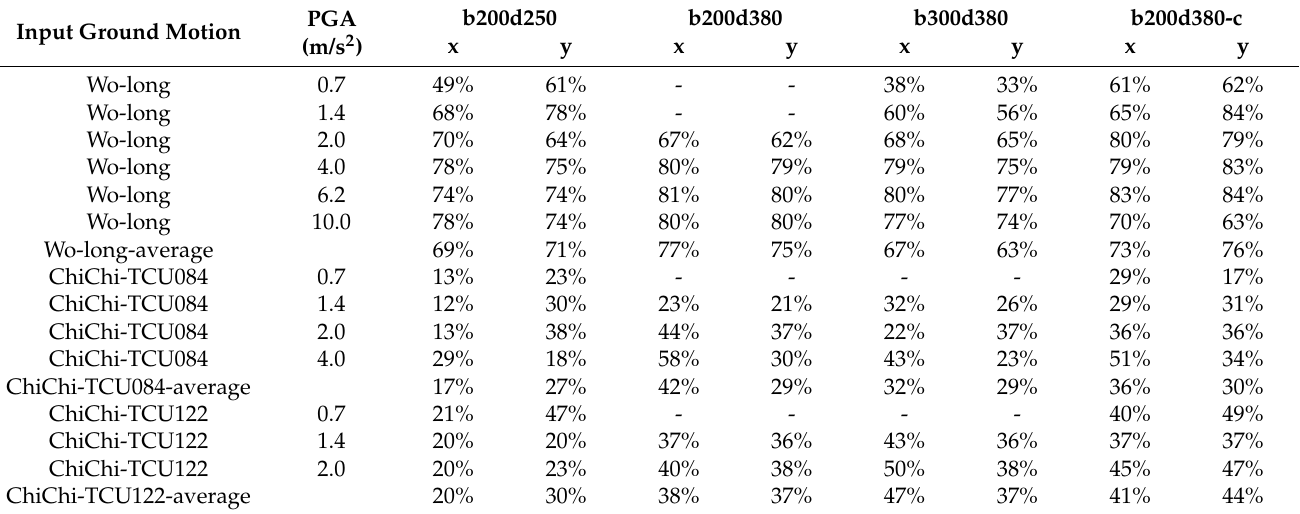
Table 5. The isolation efficiency of the variable-frequency in some representative tests.